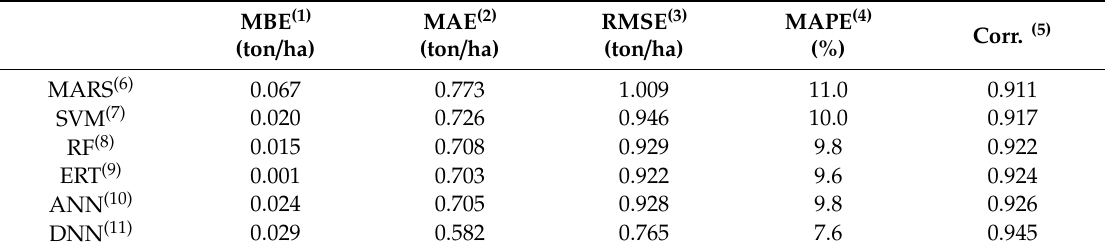
Table 6. Summary of validation statistics from 10 rounds of experiments for corn yield: July–August (JA) (major productive period),